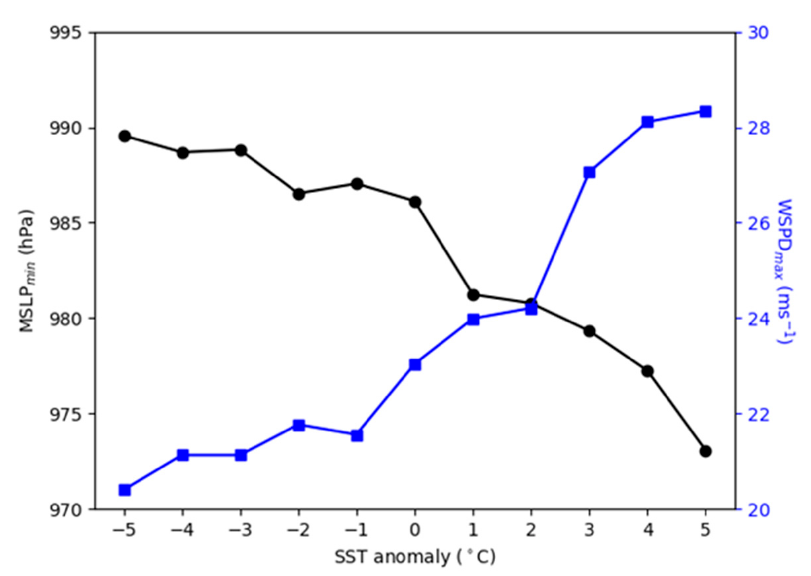
Figure 19. Minimum MSLP (black line) and maximum 10 m wind speed (blue line) at the time of the lowest central MSLP for all SST anomalies.